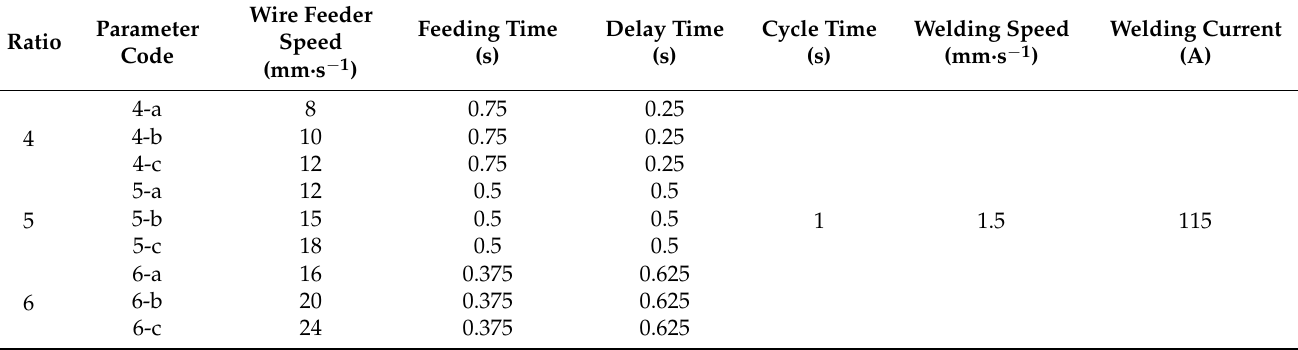
Table 1. Ratio parameter of the intermittent wire